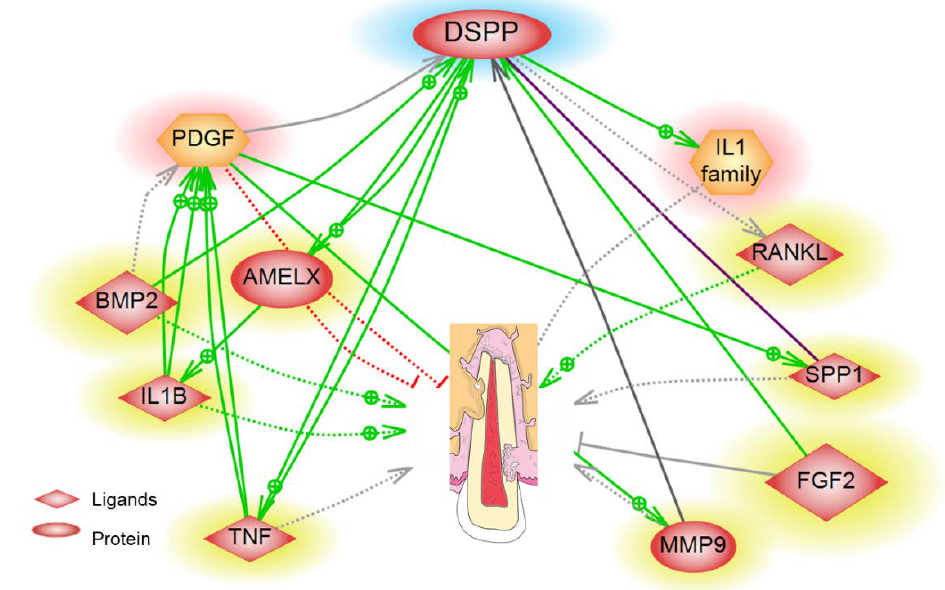
Figure 1. Systems biology analysis of the direct and indirect association between dentin-specific dentin sialophosphoprotein (DSPP) and ERR and any possible mediator proteins. A yellow halo represents a protein, and red represents a functional